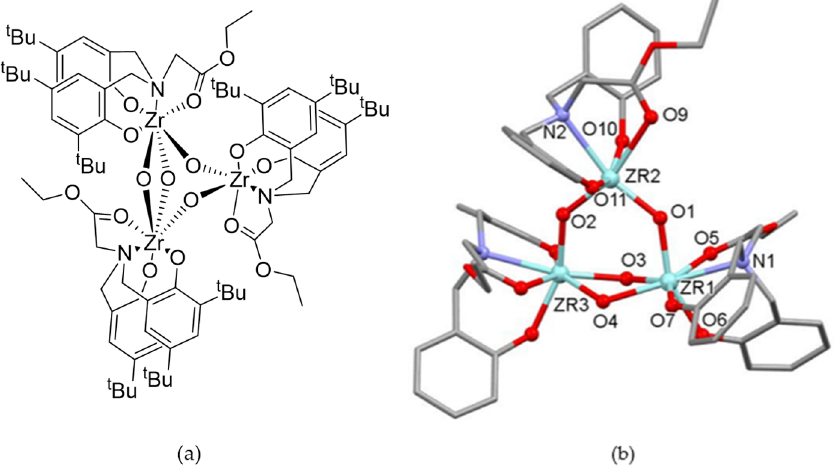
Figure 7. Structure of trimetallic Zr cluster 8 ( a ) and crystal structure of 8 ( b ). Ligand structure represented by stick and Zr and atoms bound to Zr shown by ball and stick. Hydrogens, tert -butyl groups, and solvent omitted for Selected bond lengths for 8 (Å): Zr1-O1 2.033(4), Zr1-O3 2.192(4), Zr1-O4 2.152(4), Zr1-O5 2.301(4), Zr1-O6 2.083(4), Zr1-O7 2.017(4), Zr1-N1 2.495(4), Zr2-O1 1.961(4), Zr2-O9 2.458(4), Zr2-O10 2.025(4), Zr2-O11 1.988(4), Zr2-O11 1.988(4), Zr2-N2 2.518(4). Selected bond angles for 8 (°): O1-Zr1-O3 93.0(2), O1-Zr1-O4 96.8(1), O1-Zr1-O5 82.5(1), O3-Zr1-O4 63.9(1), O9-Zr2-O10 76.0(2), O9-Zr2-N2 67.73(13), O9-Zr2-O11 83.8(1), Zr1-O1-Zr2 135.0(2), Zr1-O3-Zr3 111.4(2), Zr1-O4-Zr3 111.7(2).